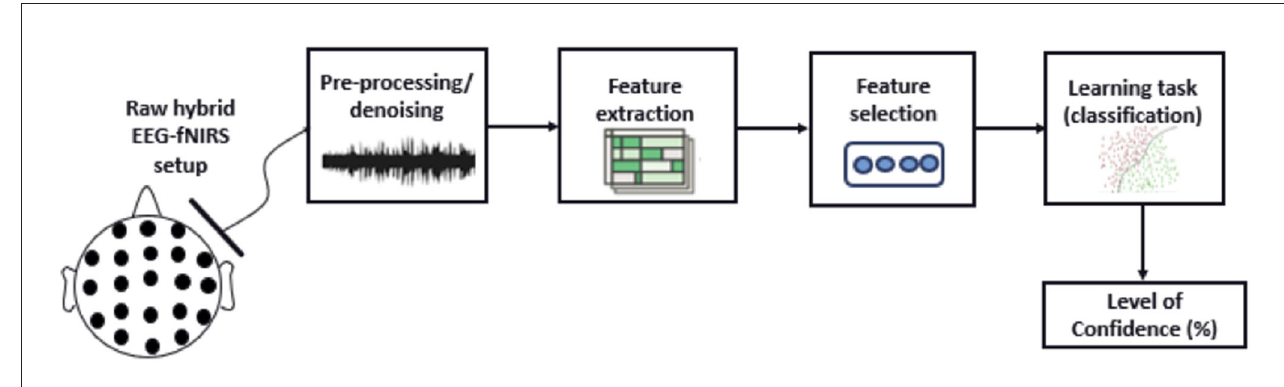
FIGURE 3 | A standard acquisition and (pre-)processing pipeline using bimodal EEG-fNIRS systems for performance-related mental state classification.